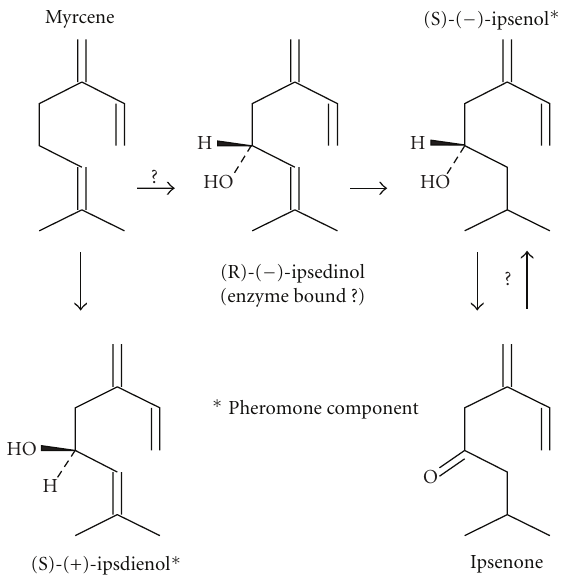
Figure 2: Proposed scheme for the conversion of the host tree compound, myrcene, to the pheromone components ( S )-( − )- ipsenol and ( S )-(+)-ipsdienol in Ips paraconfusus based on radio- labelling experiments and enantiomers found in the male [5, 7– 12, 17, 19]. Conversion arrows with question marks have not been proven. ( R )-( − )-ipsdienol does not accumulate in the hindgut but may occur as an enzyme-bound intermediate. However, contrary to the scheme, the amounts of ipsenone, ( S )-( − )-ipsenol and ( S )-(+)- ipsdienol in males were not correlated with myrcene titres in the host